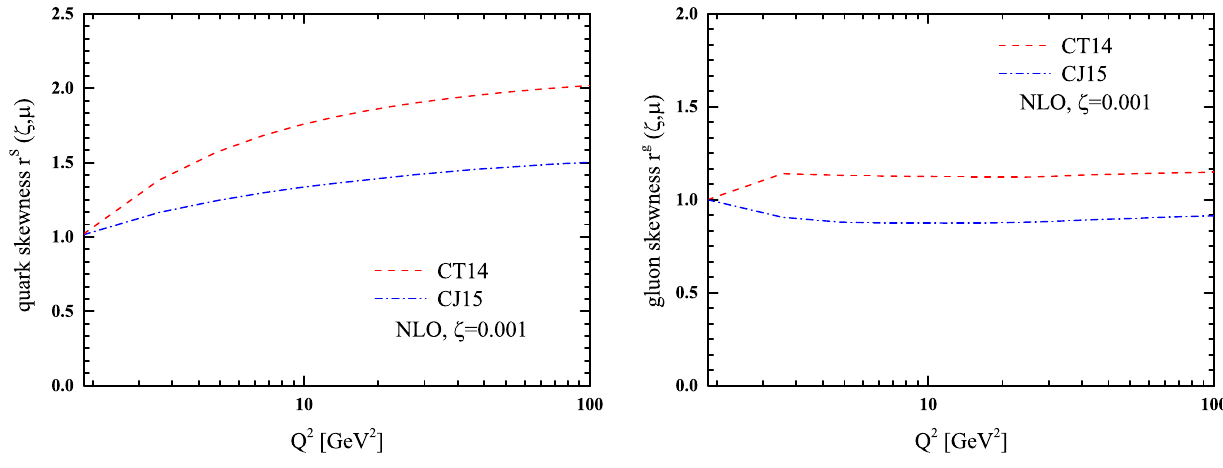
Fig. 3 The quark and gluon skewness ratios r S (ζ,μ) (left) and r g (ζ,μ) (right) as functions Q 2 = μ 2 at ζ = 0 . 001